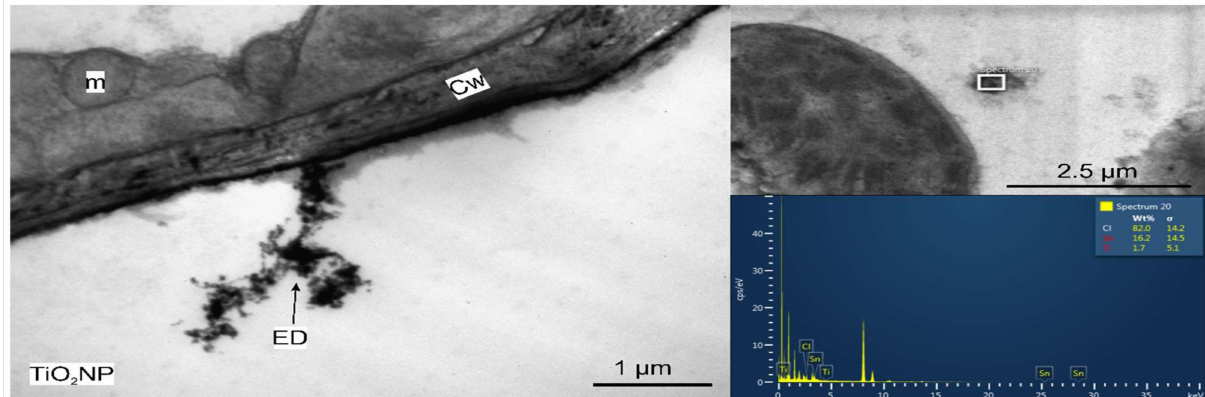
Figure 8. TEM micrograph and EDX analysis of the roots of TiO 2 treated plants. Cw = cell wall ED = electron dense particles, m =